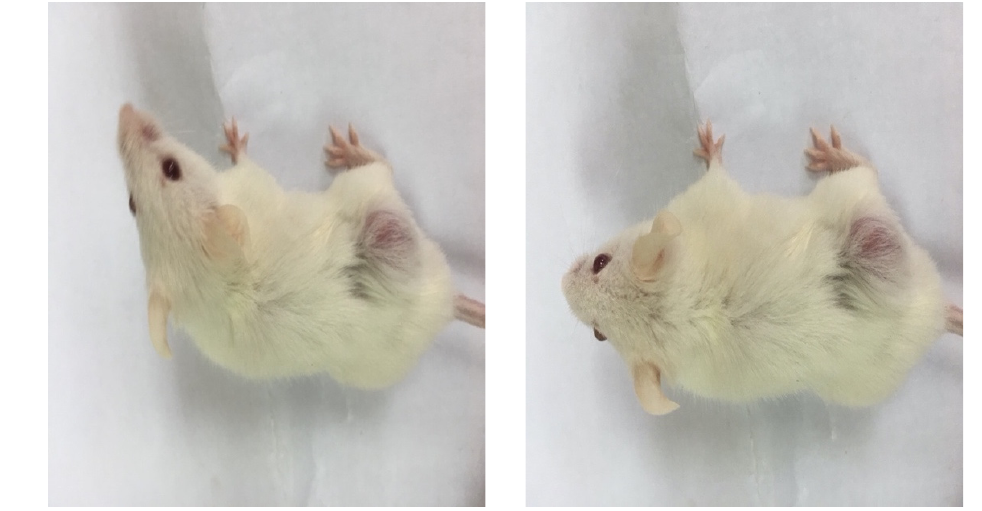
Figure 1. Tumor growth in BALB/c